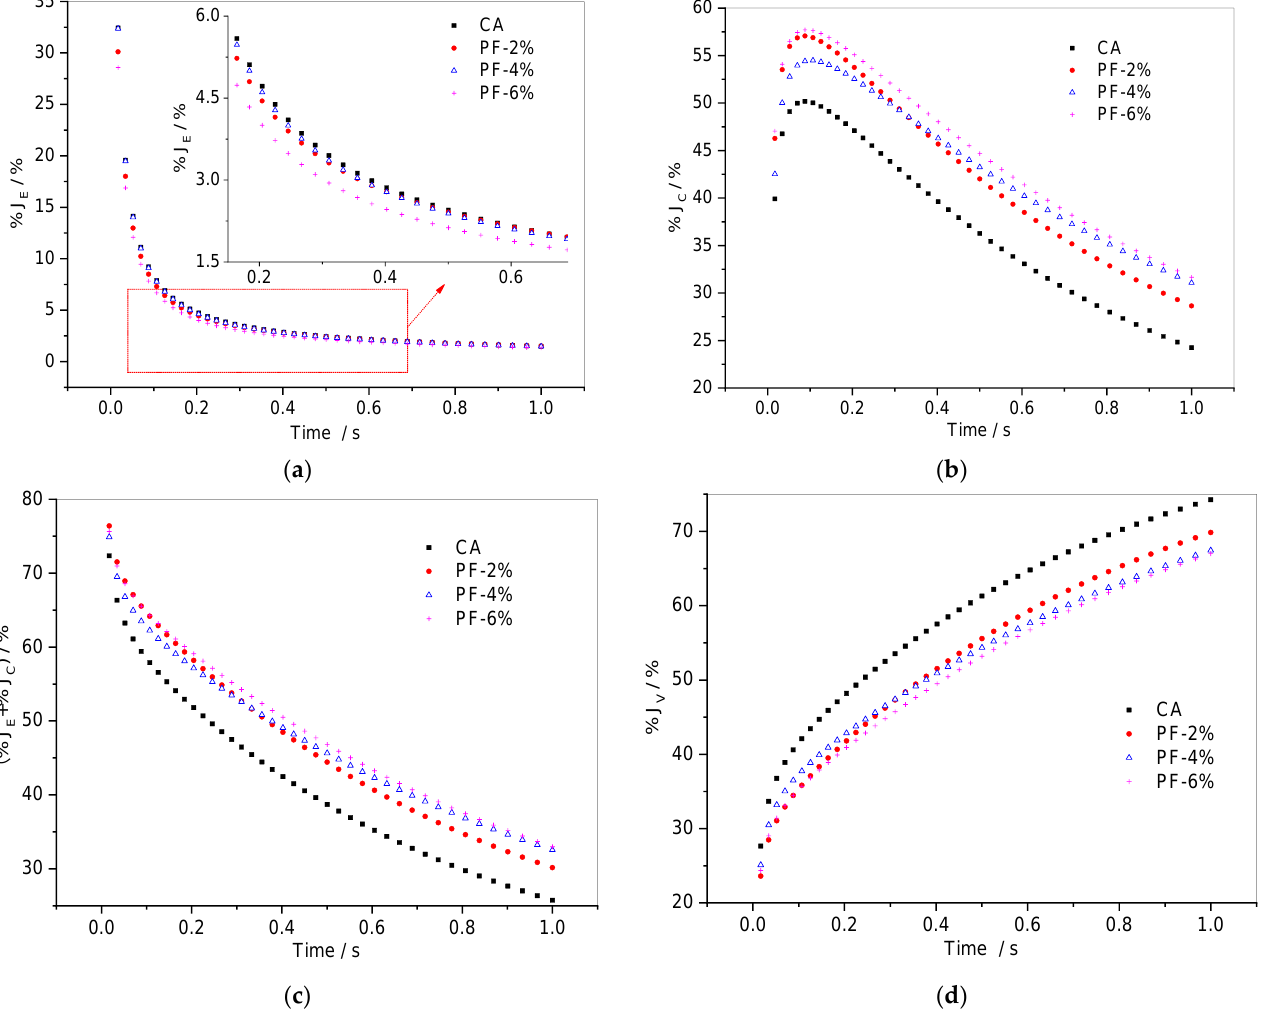
Figure 10. Evolution of ( a ) % J E , ( b ) % J C , ( c ) (% J E + % J C ), and ( d ) % J V versus time for composites with polyester fiber in the 50th cycle.